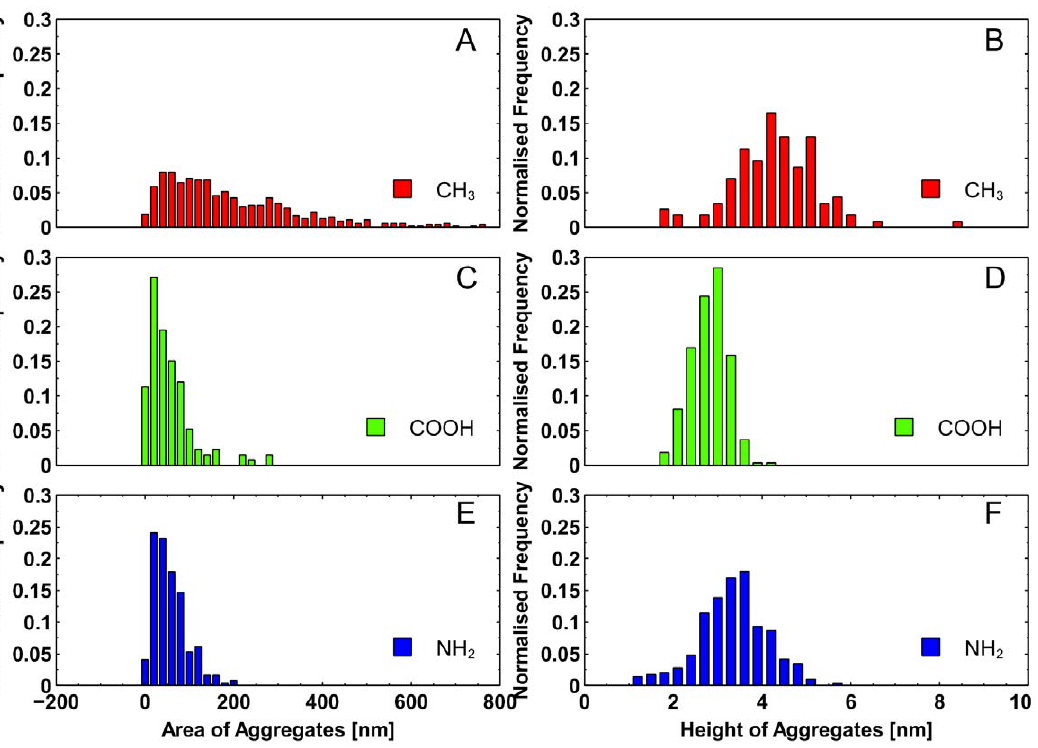
Figure 4. Statistical analysis of Aß small aggregates shown in figure 3. Histograms of aggregate unit area size (A, C, E) and height of each aggregate (B, D, F) for each surface type; (Red) CH 3 -modified surface; (green) COOH-modified surface; (blue) NH 2 -modified surface.